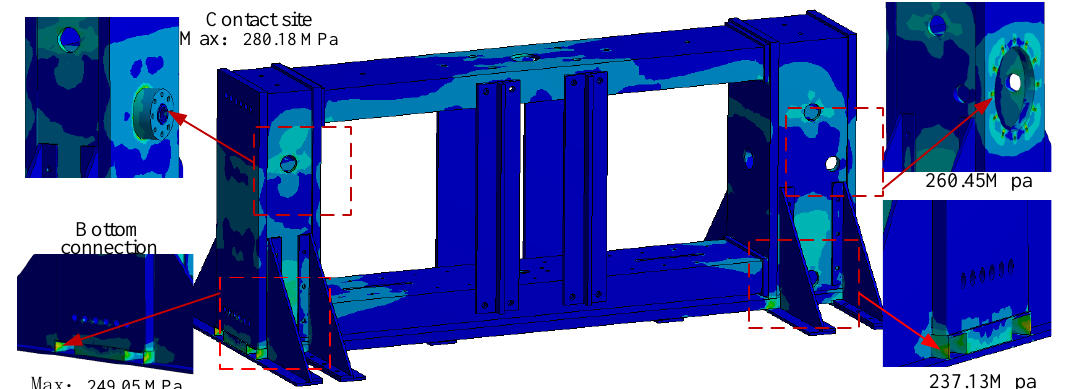
Figure 3. Loading bracket static stress analysis cloud diagram.